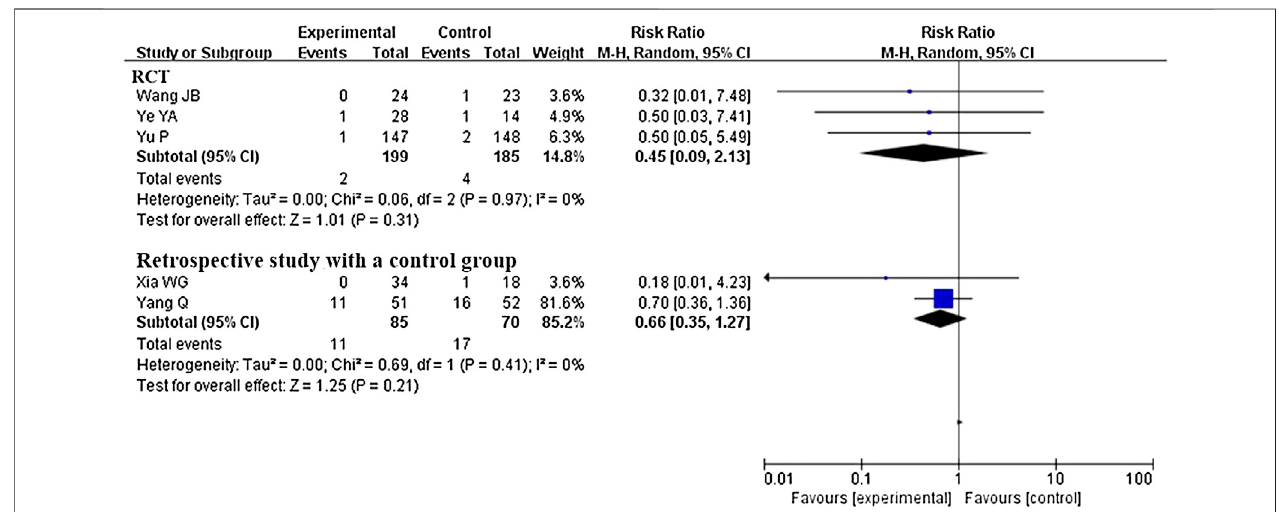
FIGURE 6 | Forest plot of mortality rate: CHM plus conventional western therapy vs. conventional western therapy.